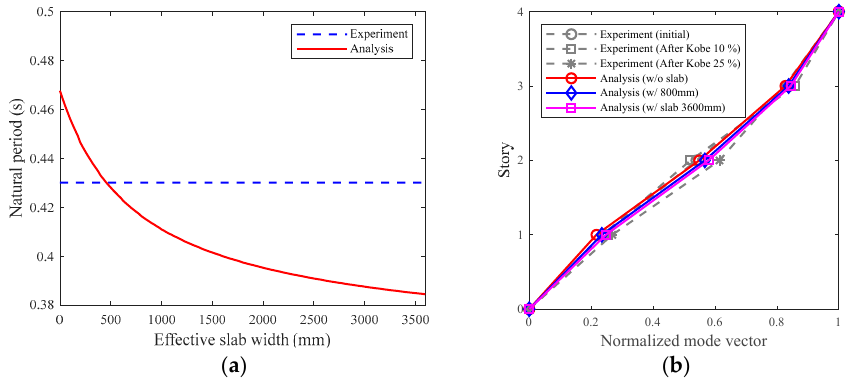
Figure 6. Results of eigenvalue analysis: ( a ) effects of effective slab width on the natural period; ( b ) effects of effective slab width on the first modal shape.